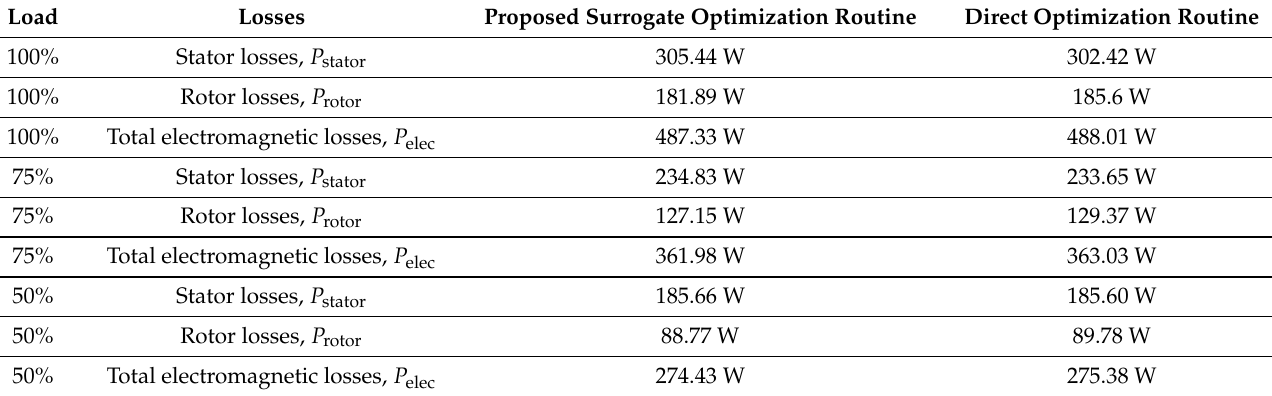
Table 19. Comparison of losses for various load points of the optimal design-proposed surrogate optimization routine vs. direct optimization